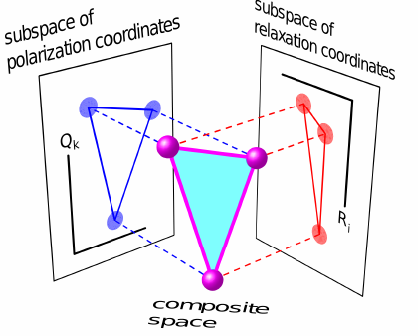
Figure 1. Schematic presentation of subspaces Q and R , as well as the composite space q = Q × R of nuclear configurations of the